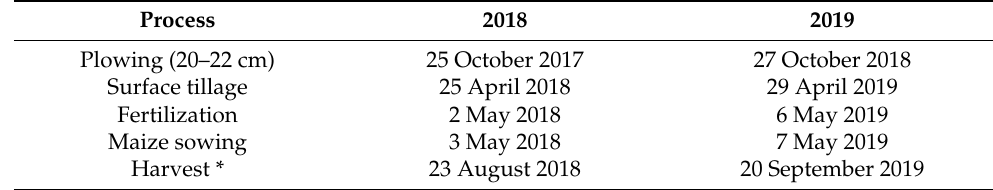
Table 2. Field preparation and maize cultivation dates in 2018 and